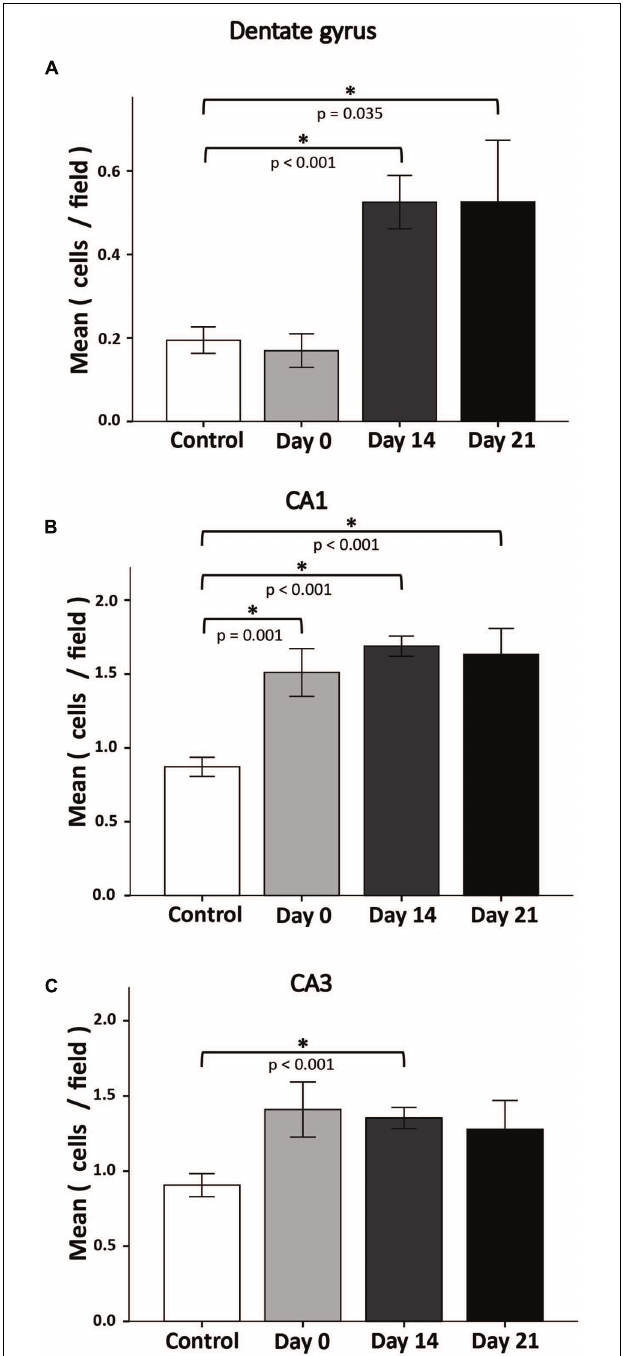
FIGURE 5 | Apoptosis rate in the DG(A), CA1(B), and CA3(C) after 72-h REM SD. Plots represent the mean ± SE of TUNEL + cells by field (445 µ m 2 ). Asterisks indicate significant differences (Mann–Whitney “ U ” test).